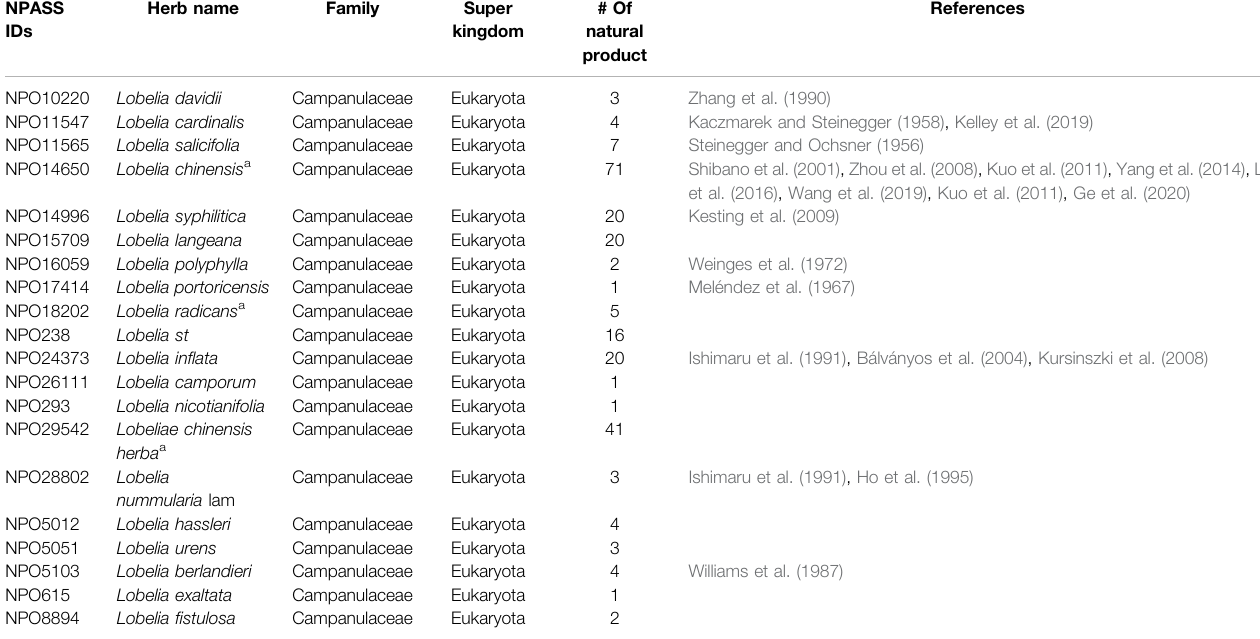
TABLE 2 | Lobelia species used in our study to investigate the neuroprotection